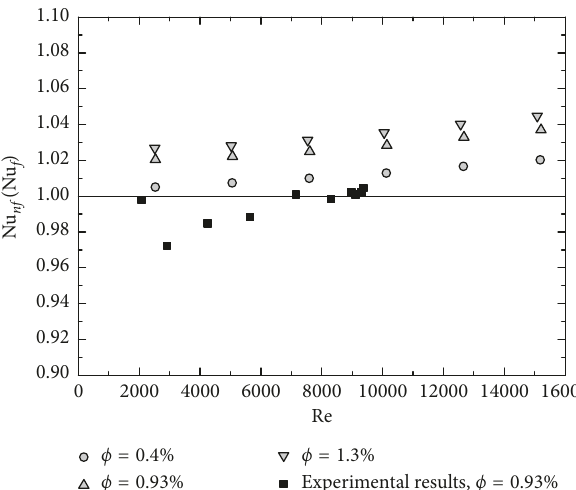
Figure 7: Nu nf /Nu f as a function of the Reynolds number by different volume concentrations ( r 8). (cid:31)